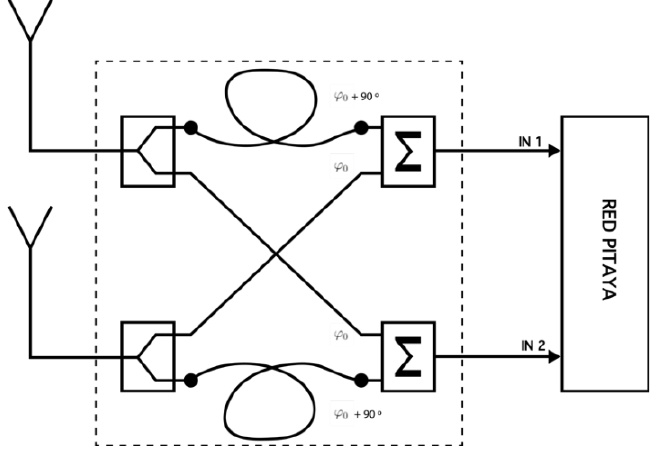
Figure 2. Diagram of the phasing network.